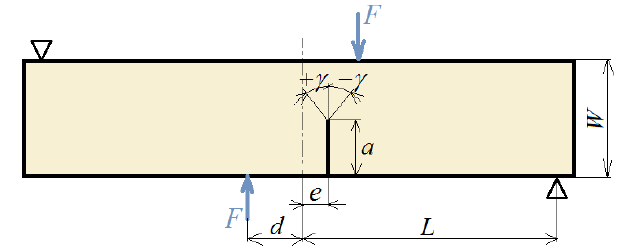
Figure 1: Eccentric asymmetric four point bending of a notched beam specimen under